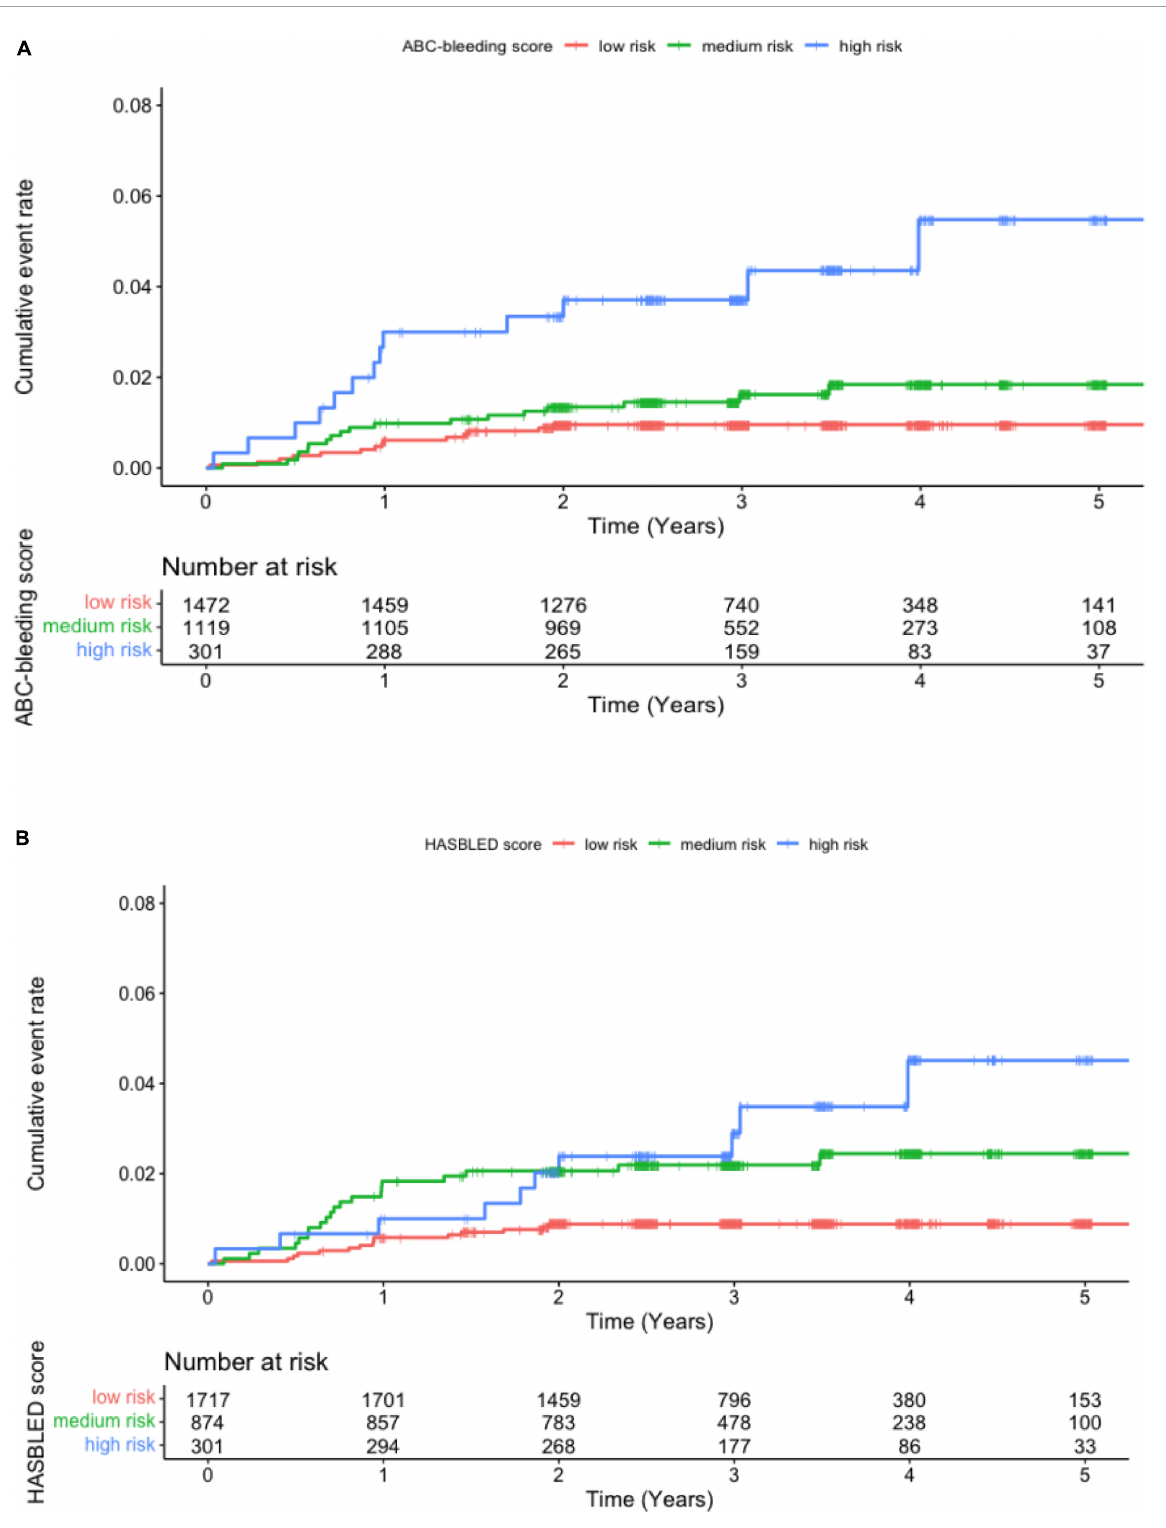
FIGURE1 Kaplan-Meier curve for major bleeding in patients at low, medium, and high risk stratified by (A) the ABC-bleeding risk and (B) the modified HAS-BLED scores.